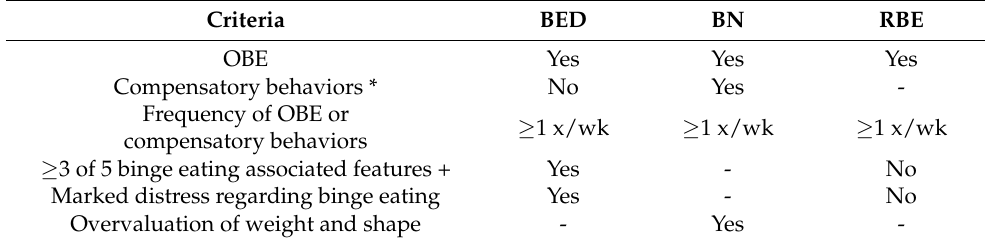
Table 1. Diagnostic criteria for BED, BN, and